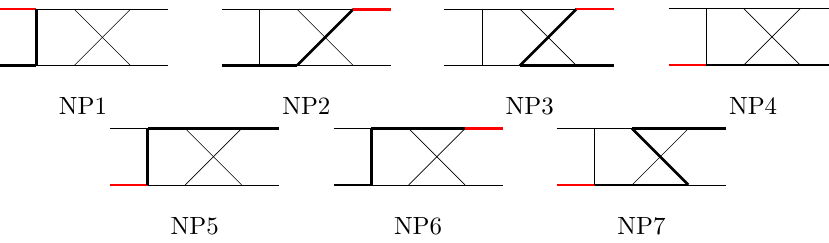
Figure 2. Non-planar integral topologies in the top sectors for gb → tW . The thick black and red lines represent the top quark and the W boson, respectively. The other lines denote massless